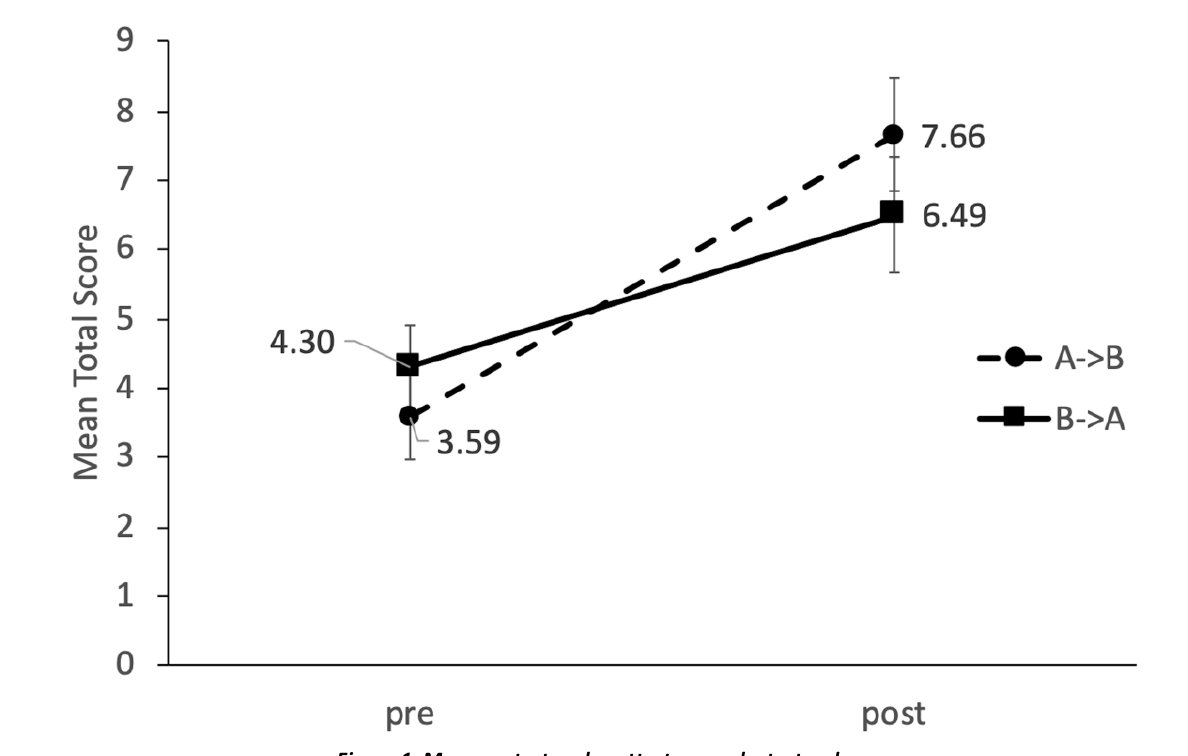
Figure 1. Mean pretest and posttest scores by test